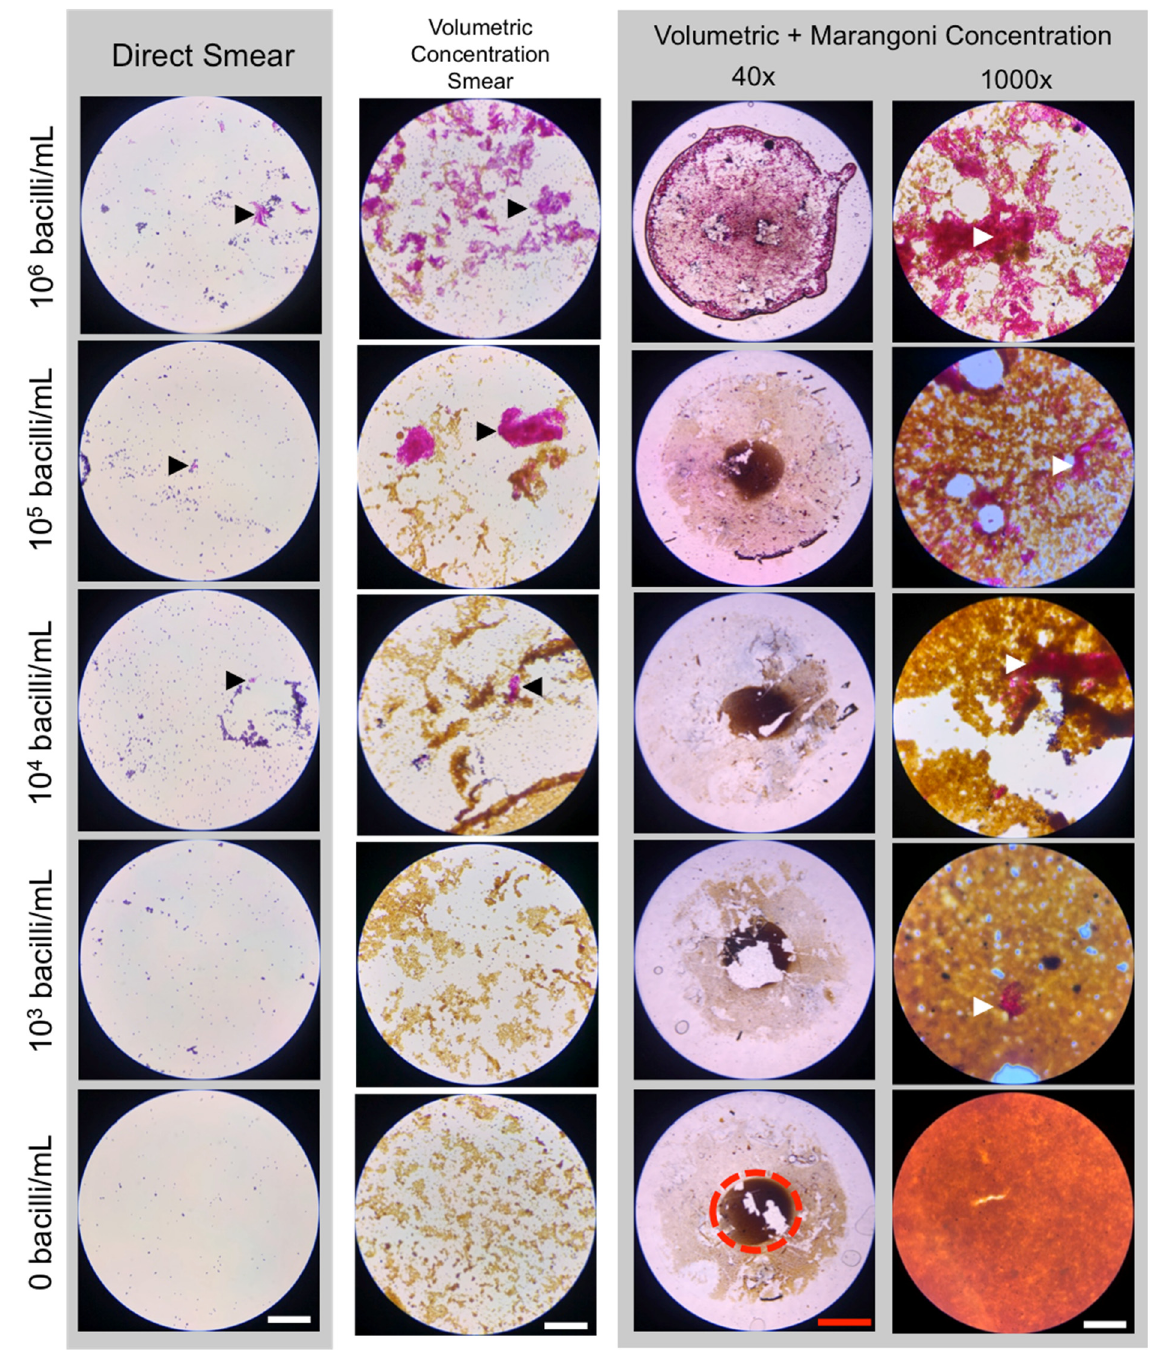
Figure 7. Effect of volumetric concentration and Marangoni spatial enrichment of 50 µ L droplets on smear microscopy (n = 3). BCG-stained pink/red with Ziehl–Neelsen stain. Nanoparticles are brown or may appear as red-orange if extremely concentrated, as seen in the lower right most image. Counterstained objects appear dark blue-purple. The most central deposition area inspected for combined volumetric + Marangoni concentration is indicated by a dashed red circle on the 0 bacilli/mL whole drop image at 40 × magnification. In the high magnification columns, 1, 2 (black), and 4 (white) arrows indicate a positive smear. Images selected were representative of the samples inspected. White scale bar = 30 µ m. Red scale bar = 300 µ